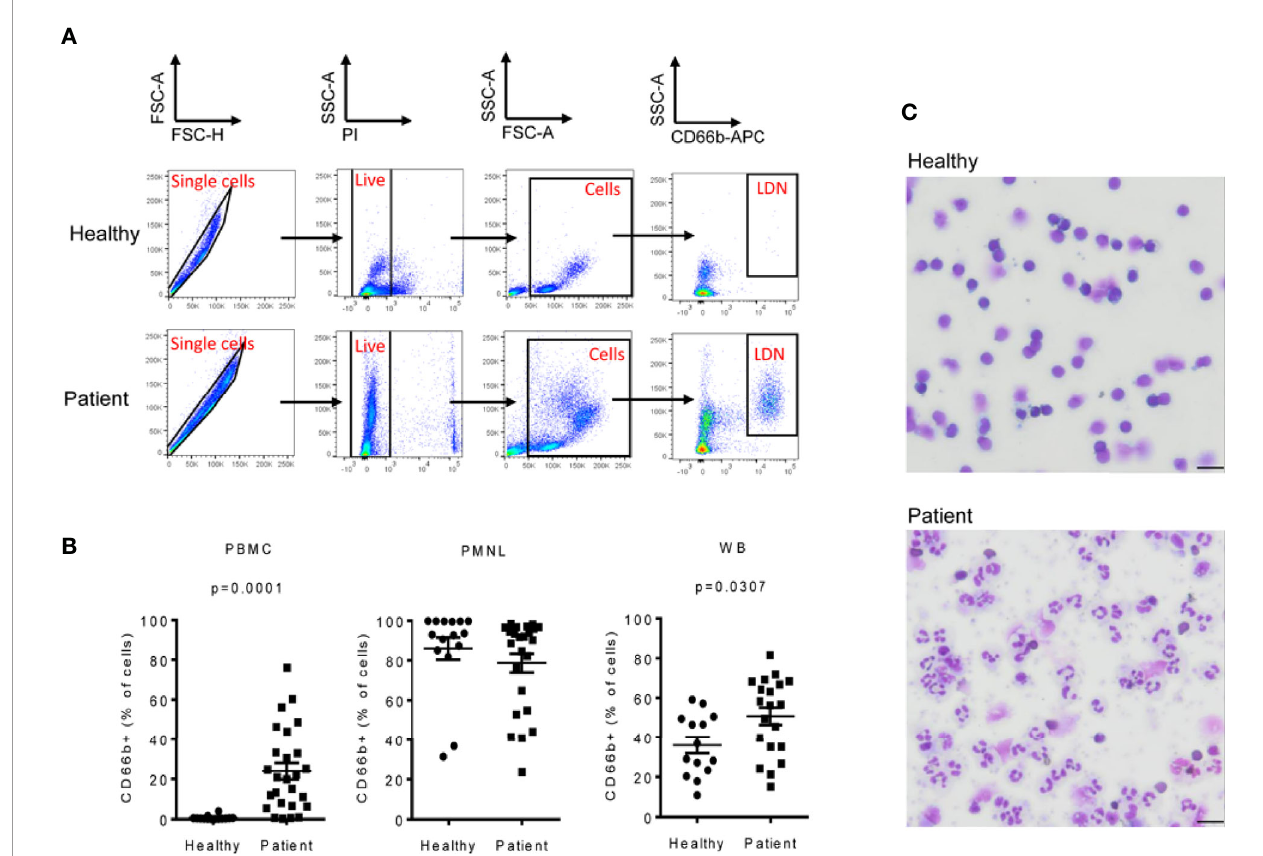
FIGURE 1 | Low-density neutrophils (LDNs) are elevated in patients with NSCLC. PBMC and PMNL fractions were isolated from peripheral blood of patients with NSCLC by density gradient centrifugation. Immediately after isolation, PBMCs, PMNLs and whole blood cells were stained with CD66b antibody to identify LDNs. (A) Representative polychromatic dot plots demonstrating the gating strategy employed to identify LDN cell content in the PBMC fraction of peripheral blood of healthy controlsandNSCLC patients. Initial gate isto eliminate doublets from the analysis followedby gating on live (PI-).Total cellswere gatedbased on theirforward and side scatter properties and LDNs were identi fi ed as CD66b + cells. (B) LDNs were quanti fi ed as the percentage ofCD66b + cells in the PBMC fraction of peripheral blood of 26 NSCLCpatients and 14 healthycontrols. Each symbolrepresents an individual donor.The percentage of CD66b + cells in the PMNL fraction andwholeblood (WB) was also evaluated. (C) Representative cytospin images of the PMBC fractionsof a healthy donor showingnoLDNs and a NSCLC patient with heterogeneousLDNs including mature (segmented nucleus)and immature neutrophils (band cells). Pictures were acquired with a 40Xobjective, bar length 20µM. Statistical differences were assessed by usingunpaired student´st-test with Welch´s correction or Mann-Whitney test and data are expressed as the mean ±